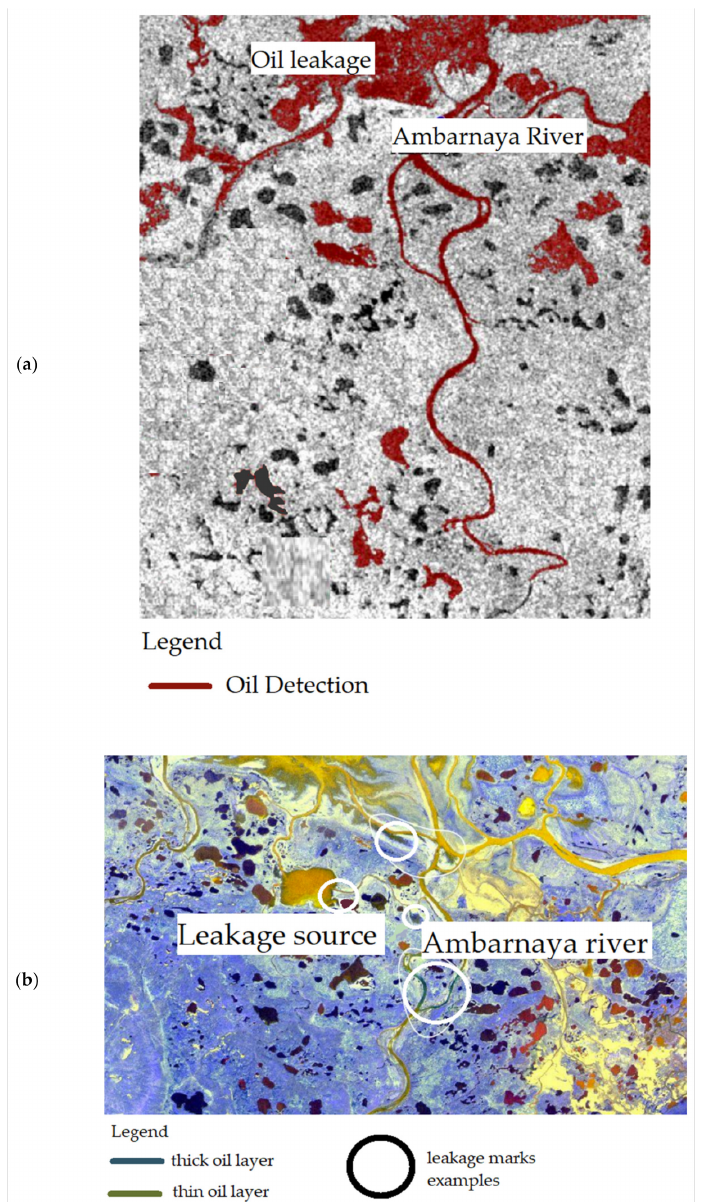
Figure 8. Oil Detection Results ( a ) from Sentinel 1 imagery (detected oil marked in red), ( b ) from Sentinel 2 imager (detected oil marked in blue and